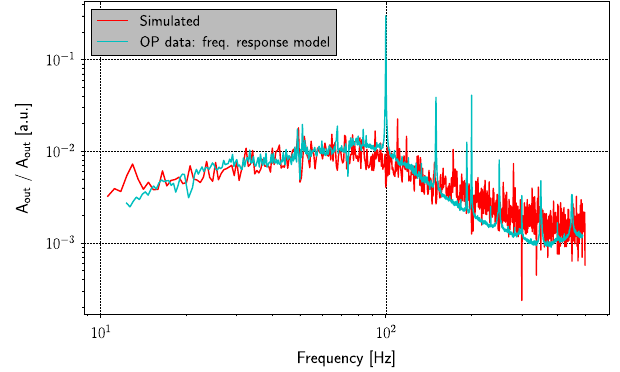
FIG. 15. Measured operational spill transfer function (light blue) compared with the simulated one (red).